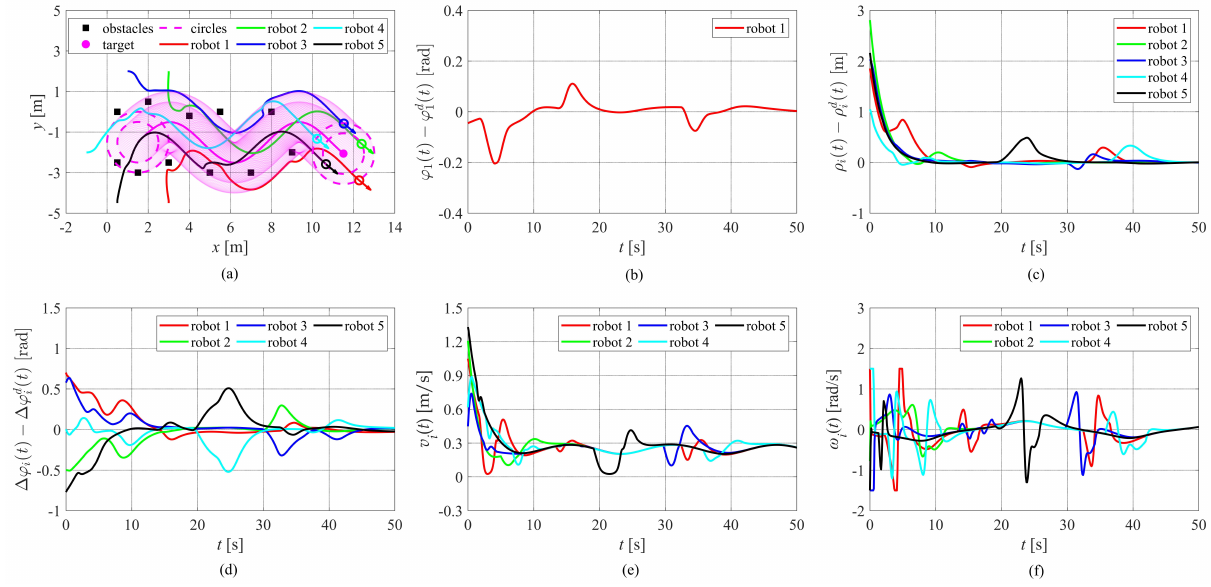
Figure 5. Simulation results of case 3. ( a ) Trajectories of five robots and a moving target with time-varying speed in a plane. ( b ) Error between current phase and the desired phase of robot 1. ( c ) Distance errors between five robots and their desired circles centered on the target. ( d ) Errors between current angular spacing and the desired angular spacing of all adjacent inter-robots. ( e ) The linear speeds of five robots. ( f ) The angular speeds of five